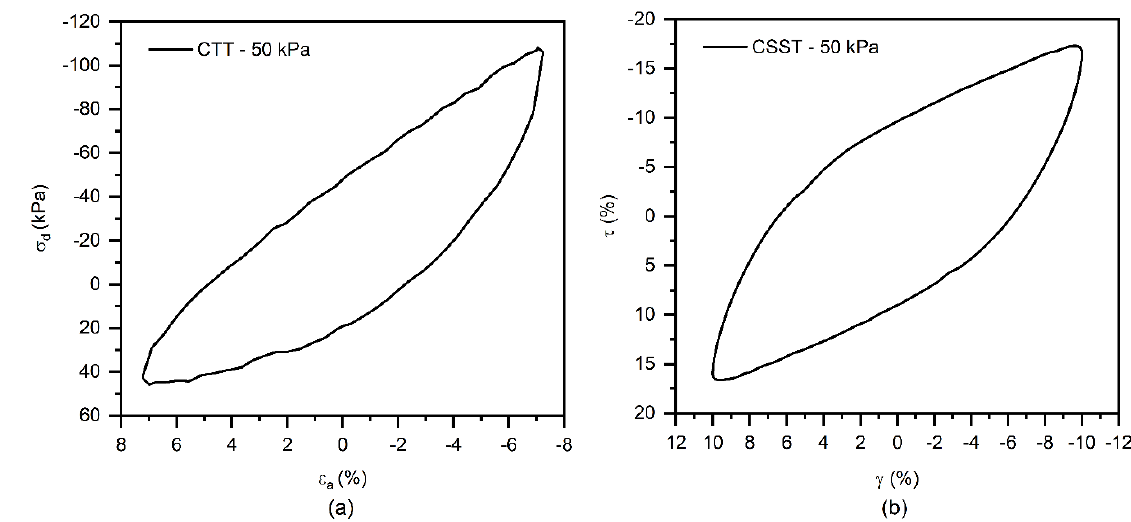
Figure 4. Hysteretic loops at γ = 10% from ( a ) CTT and ( b ) CSST.